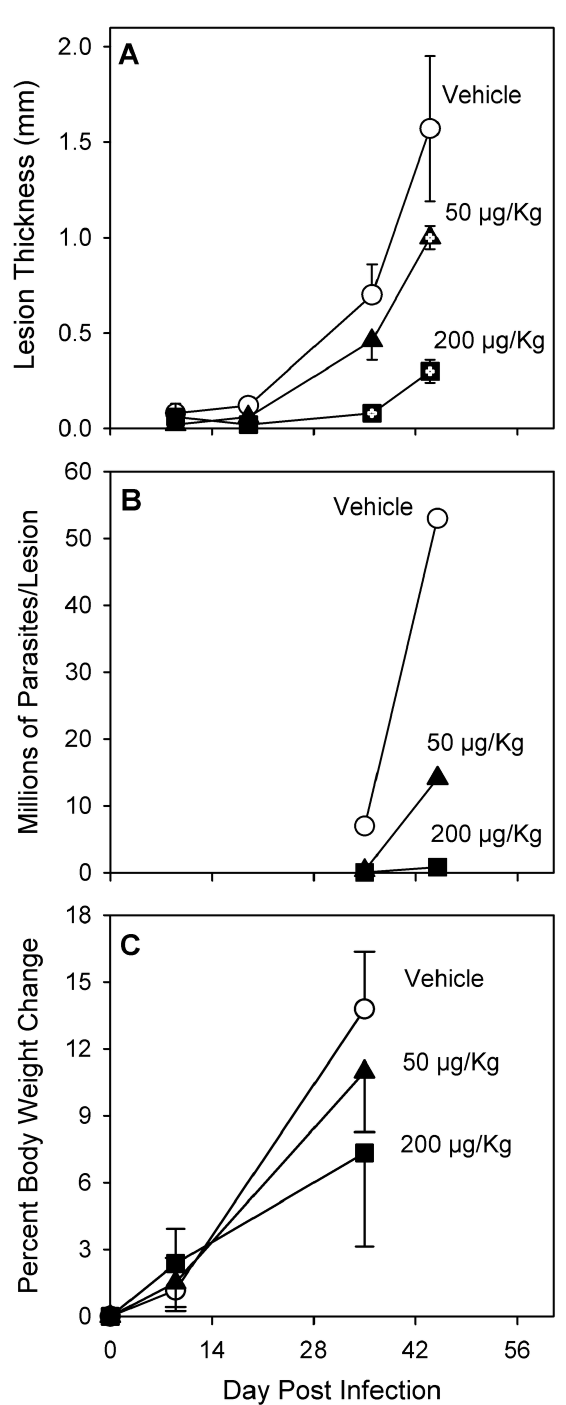
Figure 3. Effects of TCDD in SCID mice after low dose infection. Female SCID mice were treated with peanut oil (vehicle) or TCDD at various doses (per os) one day prior to infection with ten thousand stationary phase L. major promastigotes in one rear footpad. ( A ) Lesion size is shown as mean ± SEM for 3-5 mice per time point. Symbols with internal plus marks (+) indicate a statistically significant difference from vehicle mice on that day ( p < 0.05). All animals within a treatment group were euthanized following the last indicated measurement. ( B ) Mice were euthanized on the days indicated, and the infected feet of 2-3 mice per group were analyzed as a pool (n=1) for parasite burdens. ( C ) Percent body weight change is shown as mean ± SEM for 5 mice per time point. Data shown on day 35 reflects body weight change of animals measured either on day 35 or day 37. doi: 10.1371/journal.pone.0076259.g003 PLOS ONE |